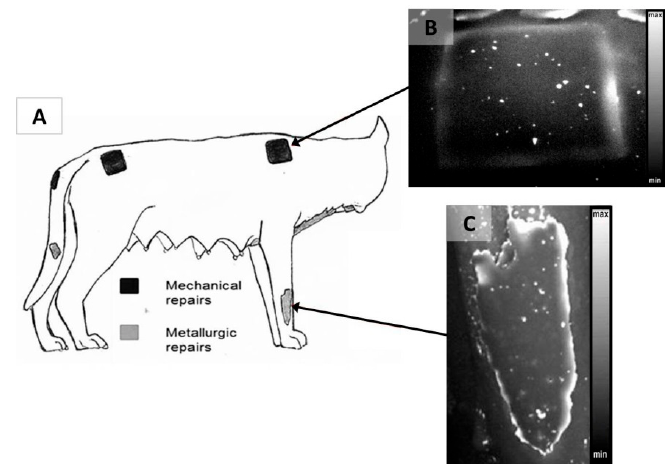
Figure 3. ( A ) Sketch of the positions of the mechanical and metallurgic repairs on the She Wolf statue; thermograms of the mechanical patch on the shoulder ( B ) and of the cast-on patch on the right front paw ( C ) [48].